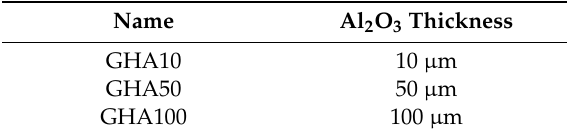
Table 1. Description of the characterized